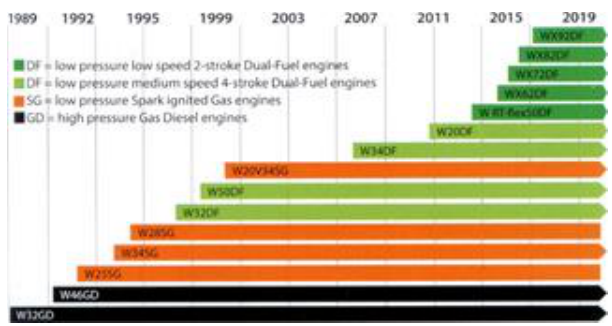
Fig. 24. Example of gaseous fuel engines development in Wärtsilä compa- ny between 1989 to 2015+ is the extensive portfolio of Wärtsilä gas- and dual-fuel engines for both two-stroke and four-stroke engine (reproduced from